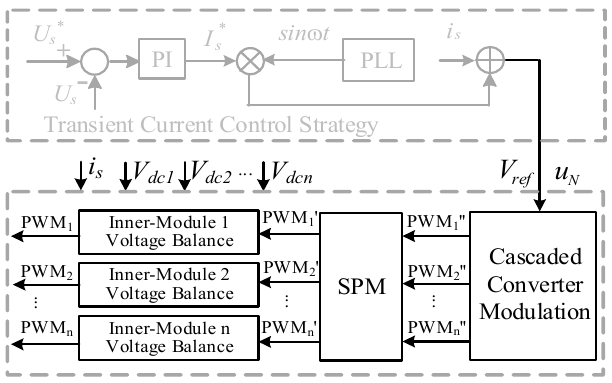
Figure 5. The control and modulation strategy of multi-module 3LNPC-CC.